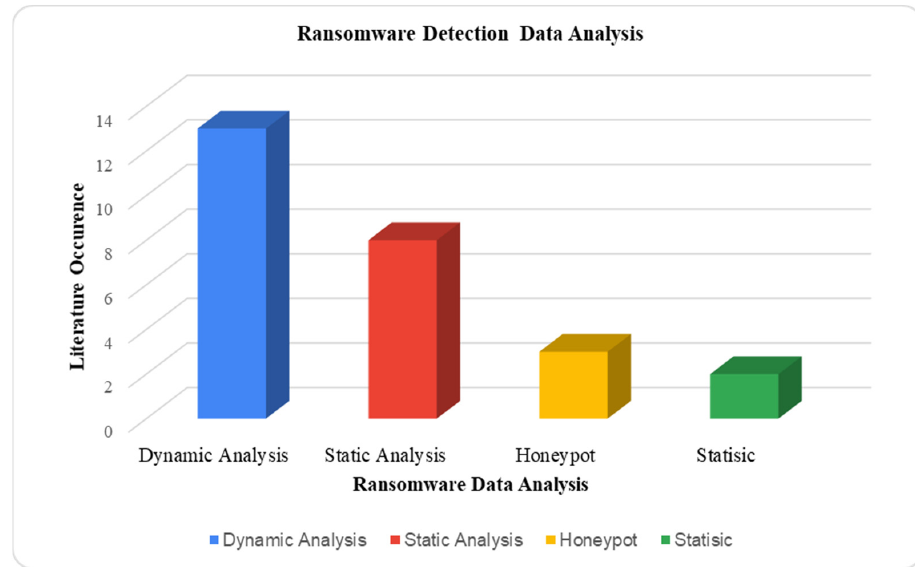
Figure 10. Data analysis approaches for ransomware detection.